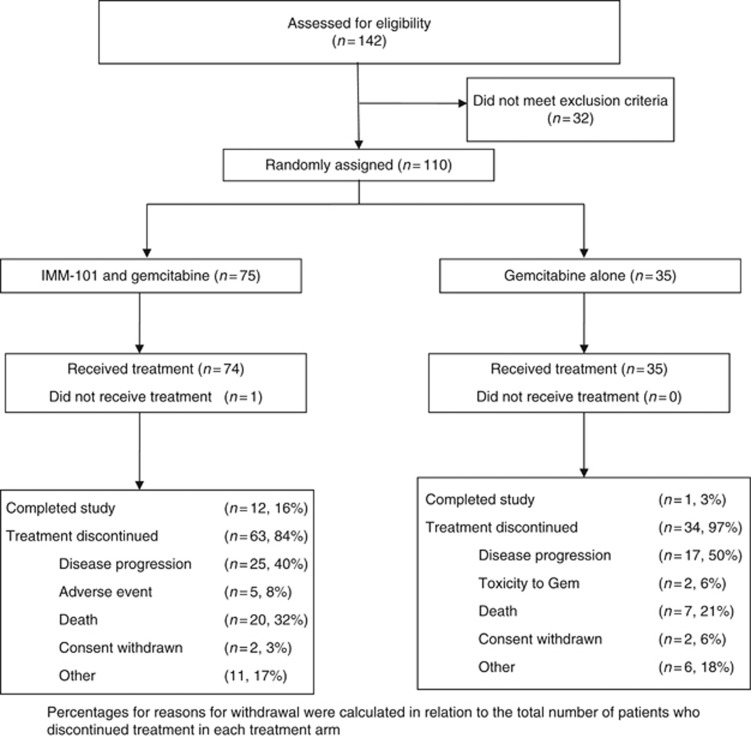
CONSORT diagram.